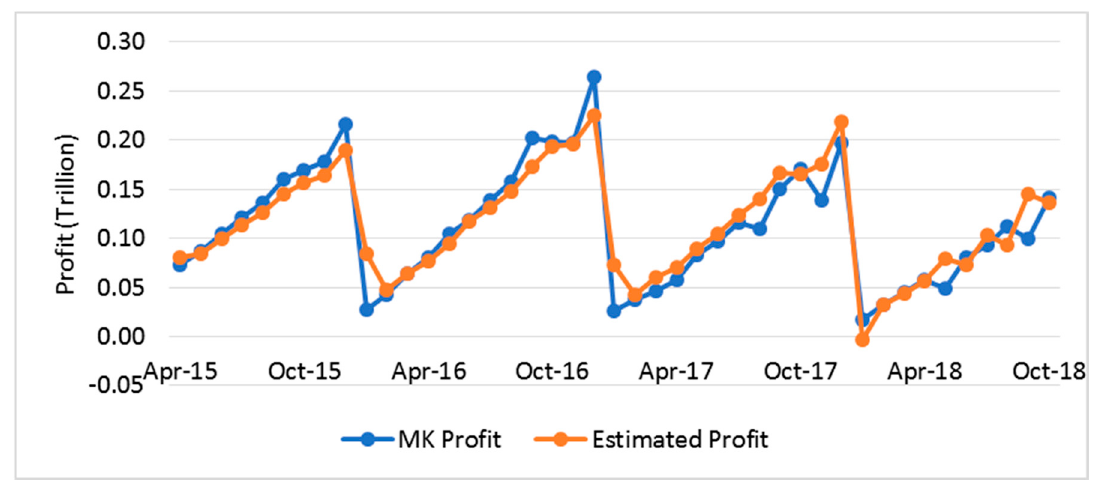
Figure 6. MK profit and estimated profit of Bank B.